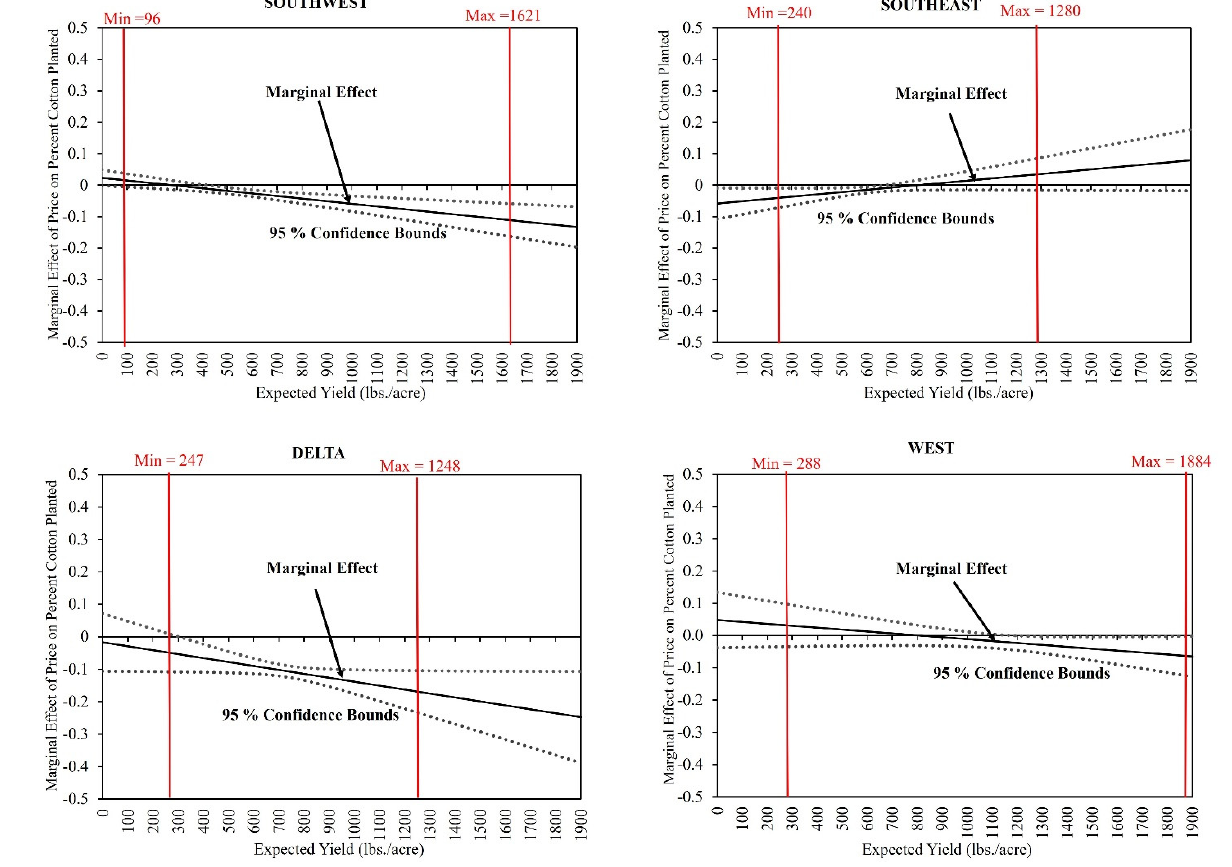
Figure 7. Marginal effects (by region) of expected price on the percentage of cotton planted given expected yields.